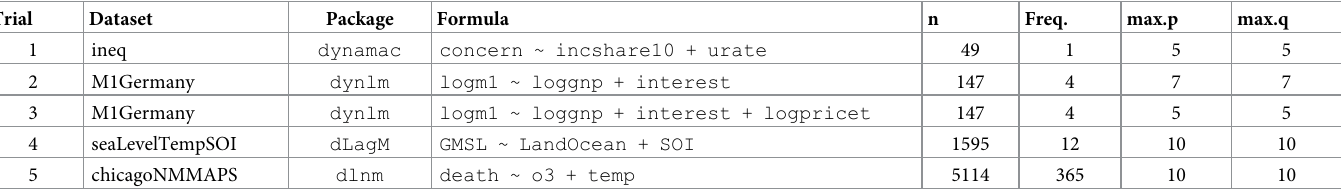
Table 1. Description of the test cases for the comparison of the full-search and the proposed algorithm for the specification of orders in the ARDL bounds testing.